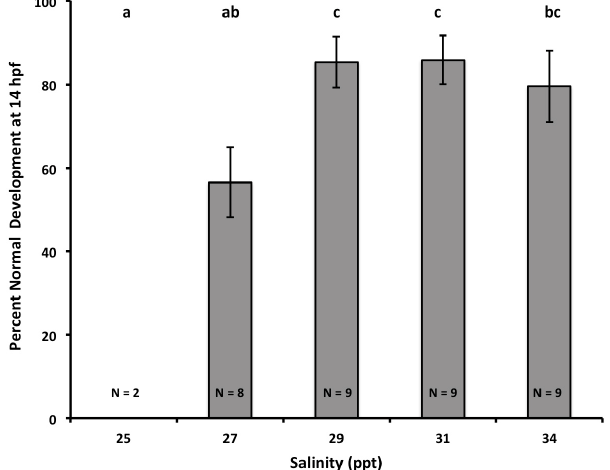
Figure 2. The percentage of embryos exhibiting normal development 14 h post fertilization (hpf) across a range of salinities (ppt). Bars represent the means (±SE) for N = 2–9 independent, replicate crosses. The number of crosses tested for a given salinity is recorded within each bar. At low salinity (25) only two crosses were conducted as no normal development was seen in either of the first two replicates. Letters above each bar denote statistically significant differences in the percentage of embryos completing normal development based on a mixed model ANOVA and post-hoc tests (see text for details).